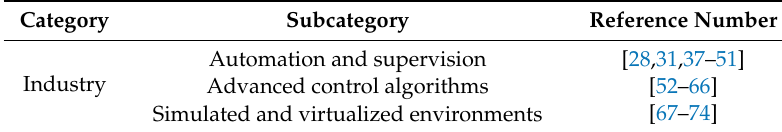
Table 2. Publications in the category of industry.